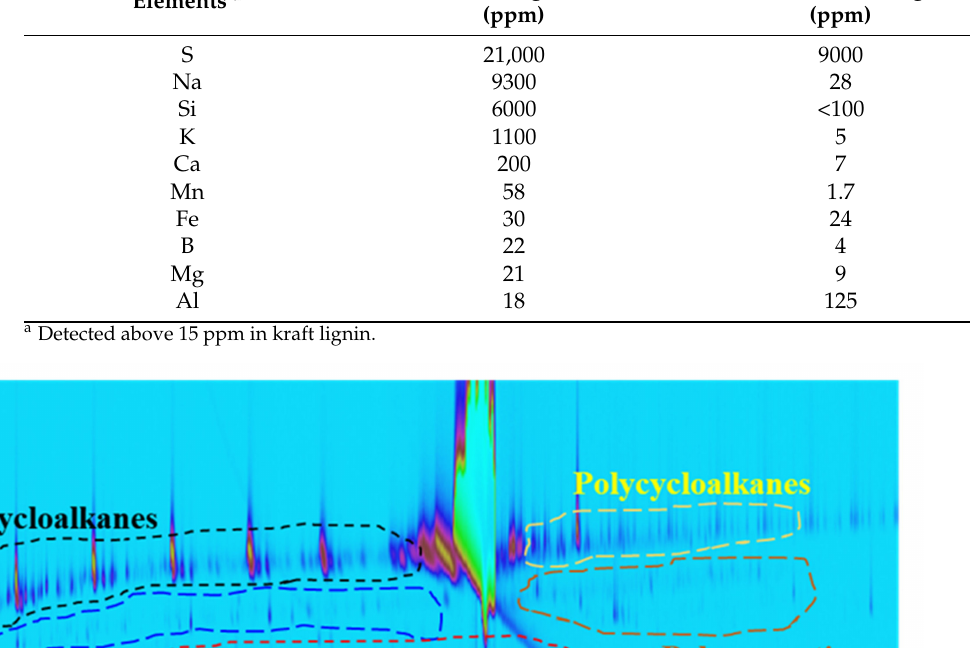
Table 1. Elemental analysis of the kraft lignin and the pretreated kraft lignin. Elements a